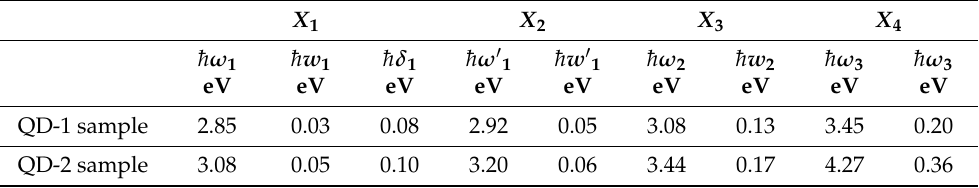
Figure 1. Absorption spectra of QD-1 ( A ) and QD-2 ( B ) quantum dots. Upper subplots show absorption spectra in the form of the second derivative. Lower subplots show absorption spectra and their decomposition into Gaussian peaks. Table 1. Gaussian decomposition of the absorption and TA spectra of QD-1 and QD-2 samples .